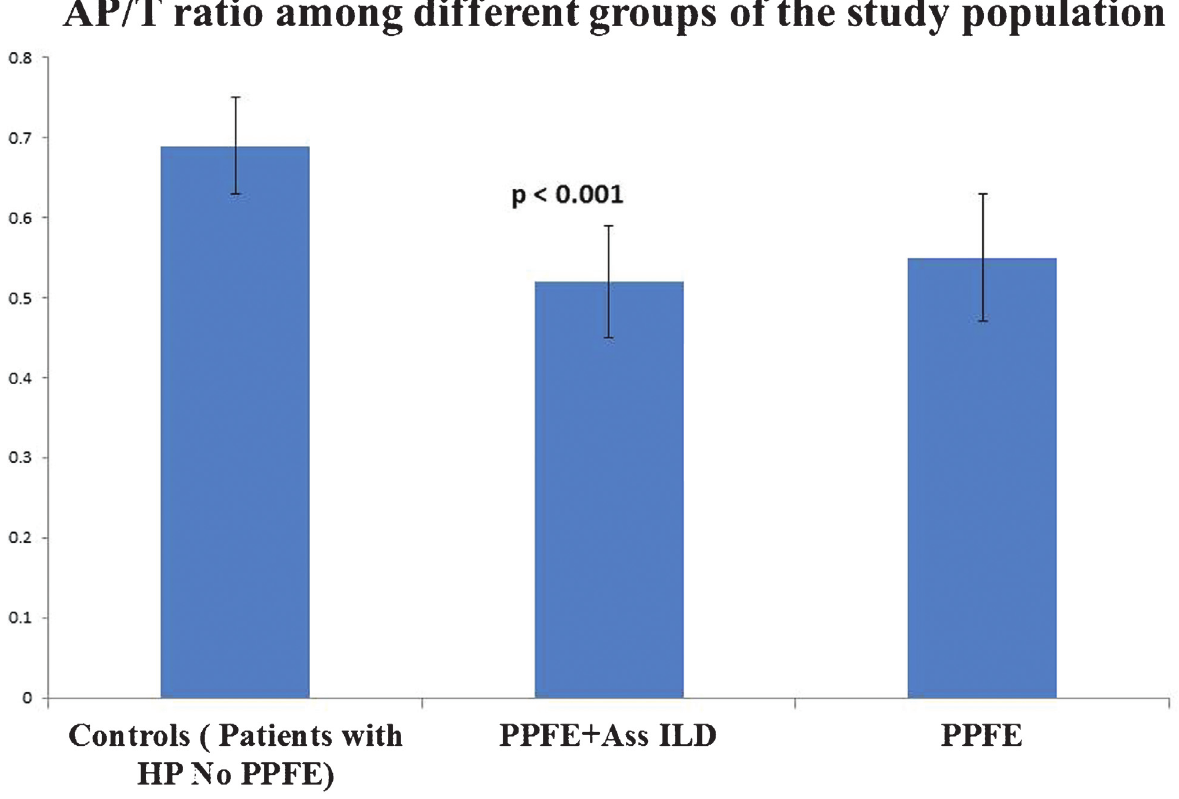
APD/TD ratio. APD, anteroposterior diameter; TD, transverse